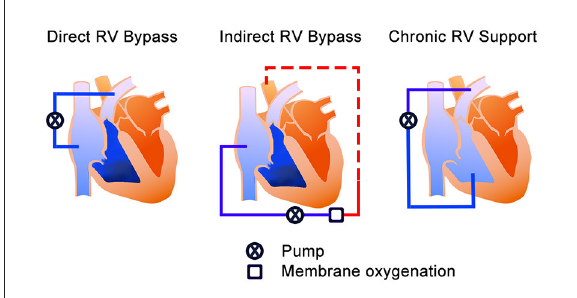
FIGURE1 The treatment mechanisms of the MCS device for RHF. The blue color is un-oxygenated blood, and the red color is the oxygenated blood. Left—Direct RV bypass mechanism; takes blood from the systemic veins and pumps it to the pulmonary artery. Middle—Indirect RV bypass mechanism; takes the blood from systemic veins and provides systemic perfusion (red dash line) from the femoral artery. Right—RV support mechanism; takes blood from the RV and pumps it to the pulmonary artery. RV, right ventricle; MCS, mechanical circulatory support; RHF, right heart failure.